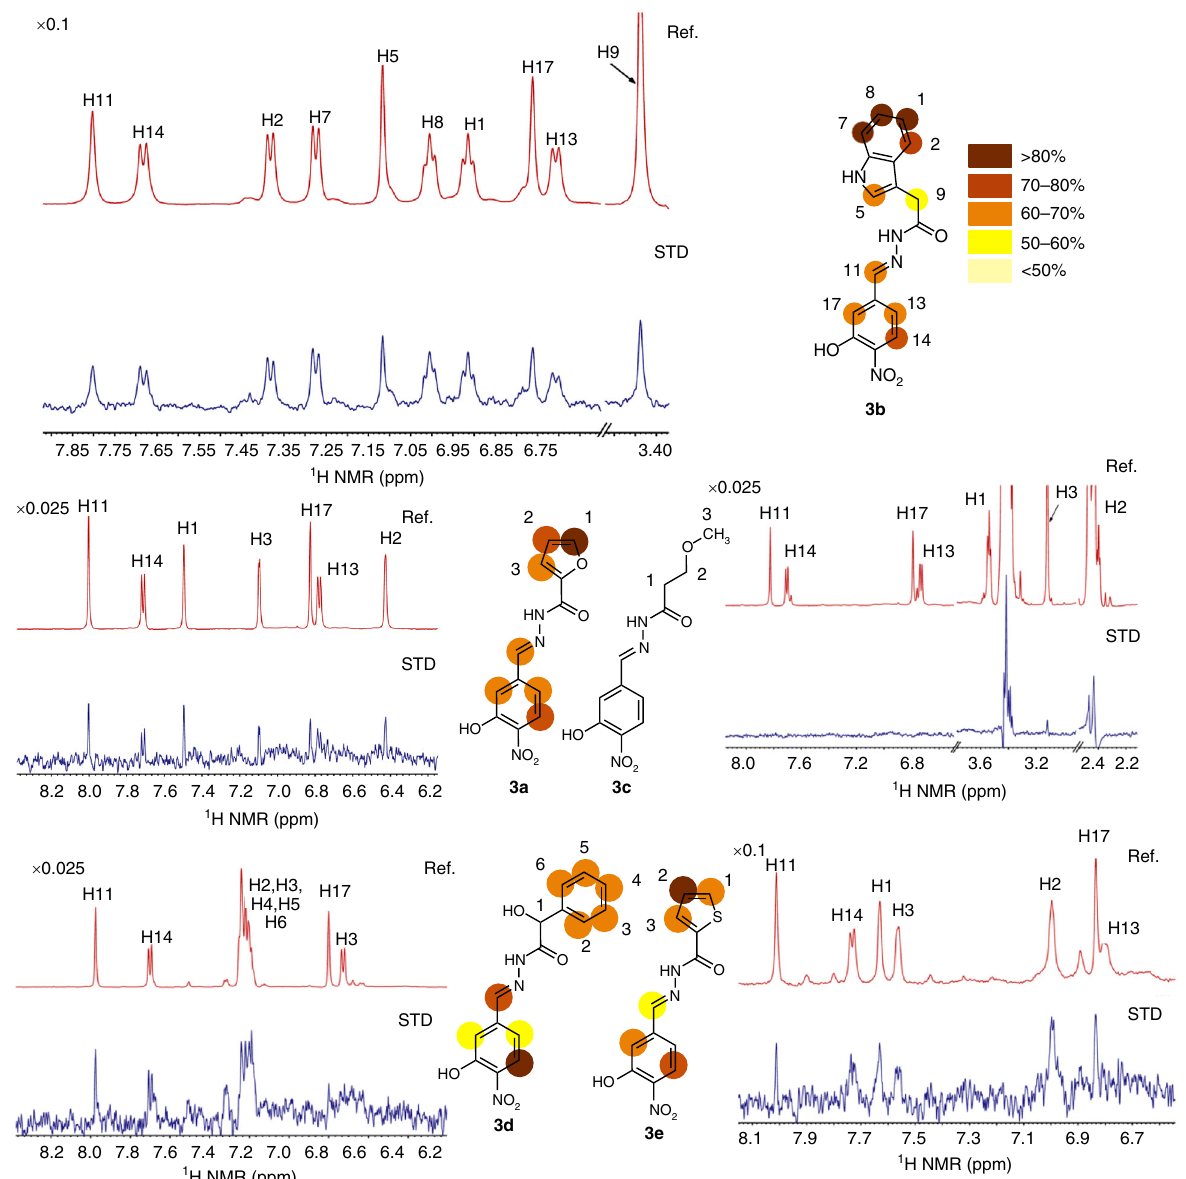
Fig. 5 1 H-STD-NMR spectra of 3a – 3e in the presence of d NCS-1. STD (blue) and off-resonance (red) NMR spectra acquired for compounds 3a – 3e (1 mM) in the presence of 10 μ M d NCS-1 (600 MHz, 281 K). Relative STD intensities are coded according to the color scale shown. The 100% STD signal corresponds to the resonance showing the highest intensity in each case and all other STD signals are calculated δ 2.2 ppm. corresponding to 2c , the acylhydrazide precursor of 3c . Thus, d NCS-1 induces the synthesis of 3b , a d NCS-1 ligand, at the expense of 3c , which is not bound to the protein.